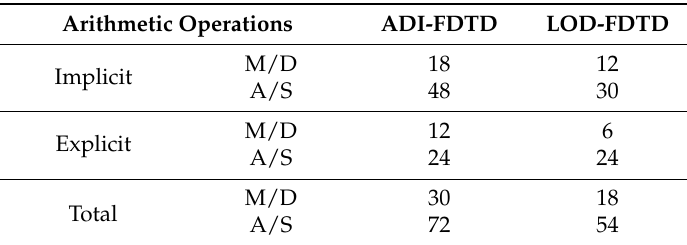
Table 3. Comparison of 3D LOD-FDTD and ADI-FDTD in terms of Arithmetic Operation Counts. Arithmetic Operations ADI-FDTD LOD-FDTD M/D 18 Implicit